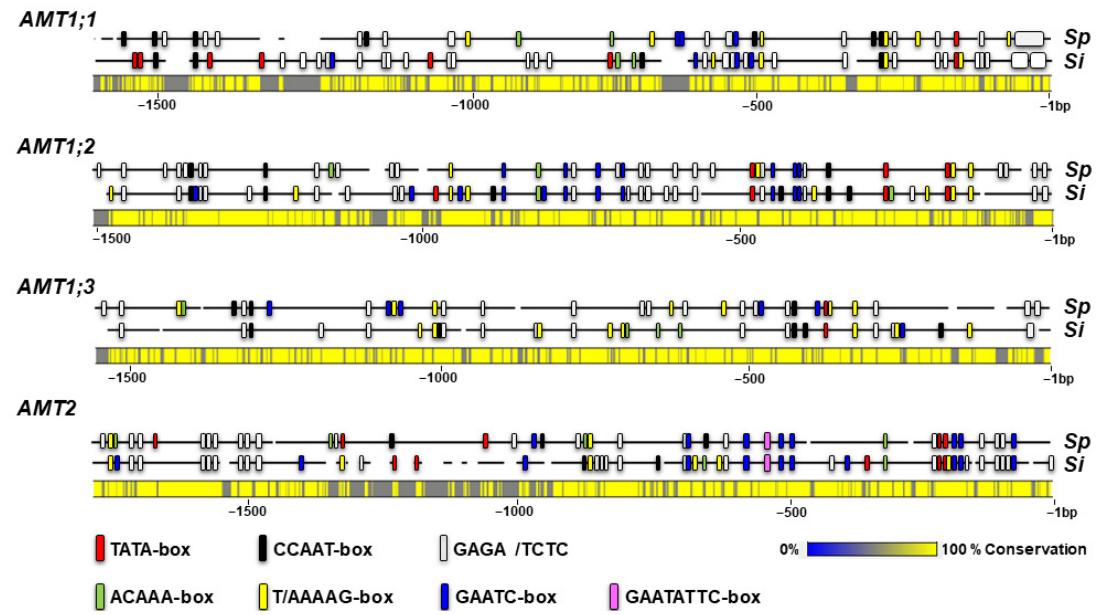
Figure 6. Schematic representation of promoters of the four AMT genes ( AMT1;1 , AMT1;2 , AMT1;3 and AMT2) in the genomes of Spirodela polyrhiza ( Sp) and Spirodela intermedia ( Si ). The negative numbers represent distance from the first ATG codon in nucleotides (bp). Colored boxes indicate locations of the corresponding promoter cis -elements. The conservation bar refers to the level of similarity between the homologous promoter sequences of Spirodela polyrhiza ( Sp ) and Spirodela intermedia ( Si)